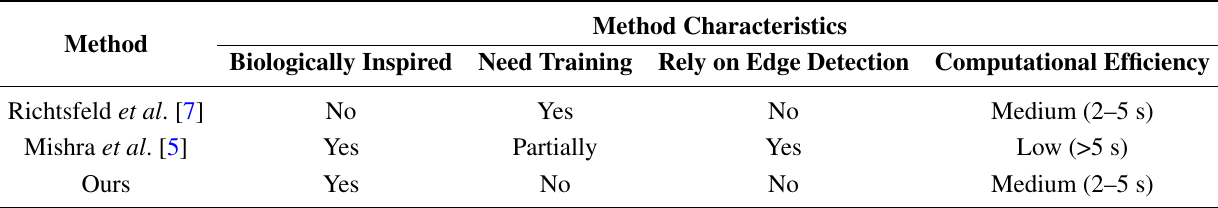
Figure 9. Visual examples of unknown object detection on the RGB-D scene dataset. Table 6. Comparison of the method